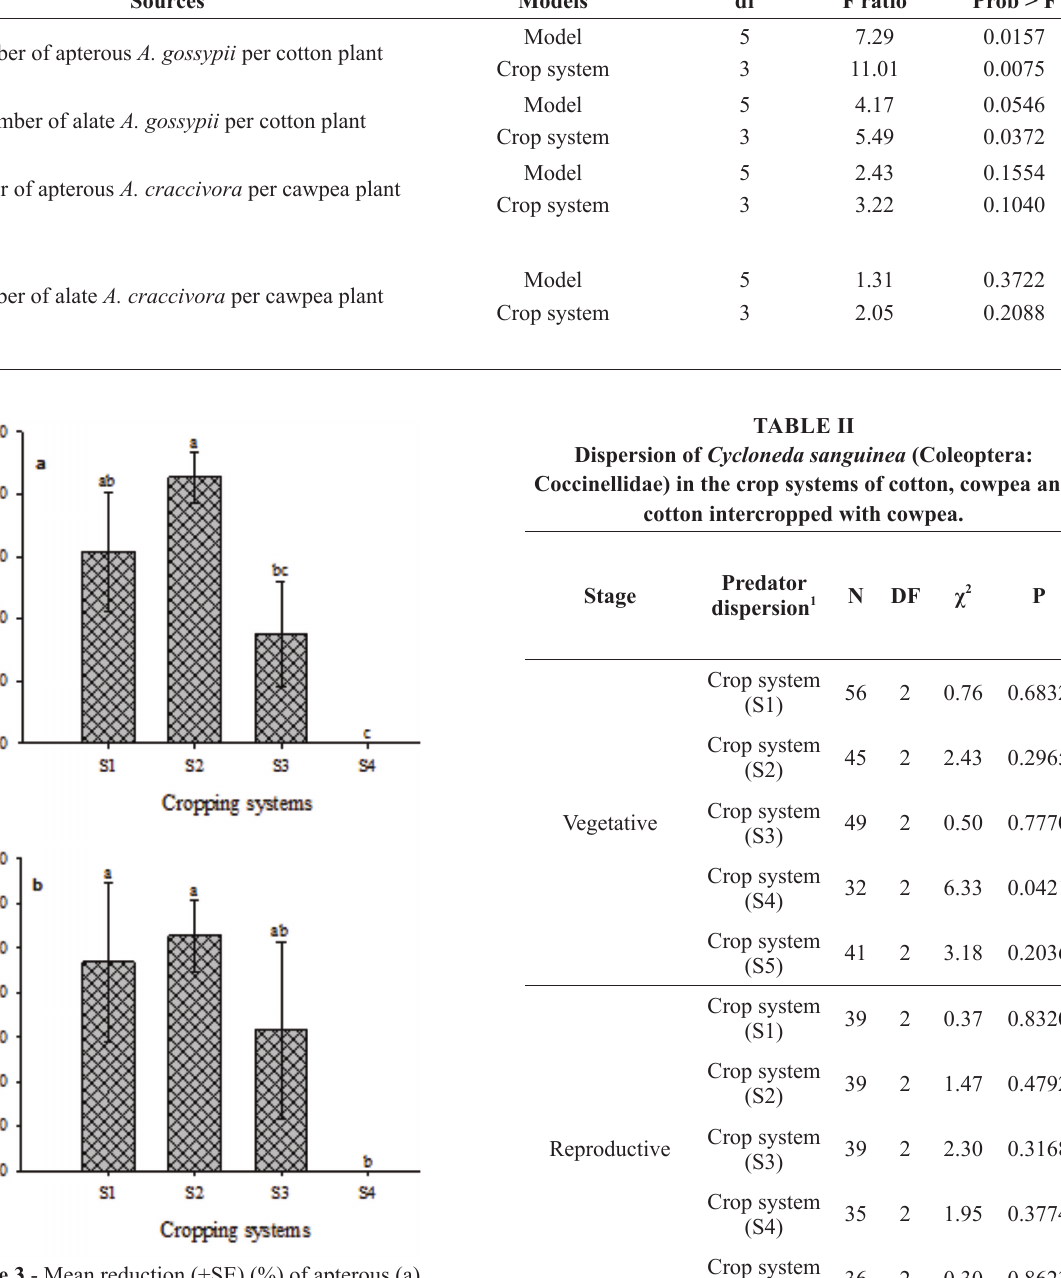
Figure 3 - Mean reduction (±SE) (%) of apterous (a) and alate (b) Aphis gossypii (Hemiptera: Aphididae) in the cropping systems of cotton (S4) and cotton intercropped with cowpea systems (S1, S2, and S3). Error bars indicate SE. Within each figure, different letters indicate differences (SNK test; P =